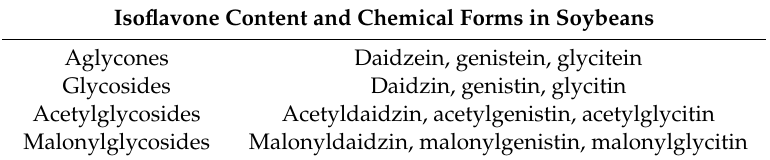
Table 1. Presence of four chemical forms of the three isoflavones found in soybeans.